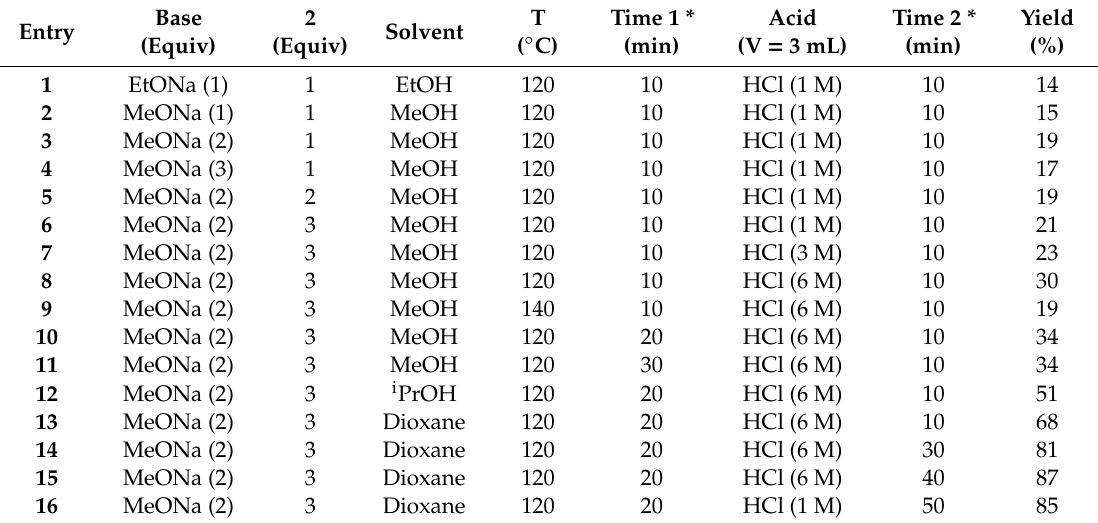
Table 1. Microwave-assisted optimization conditions for the synthesis of compound 3